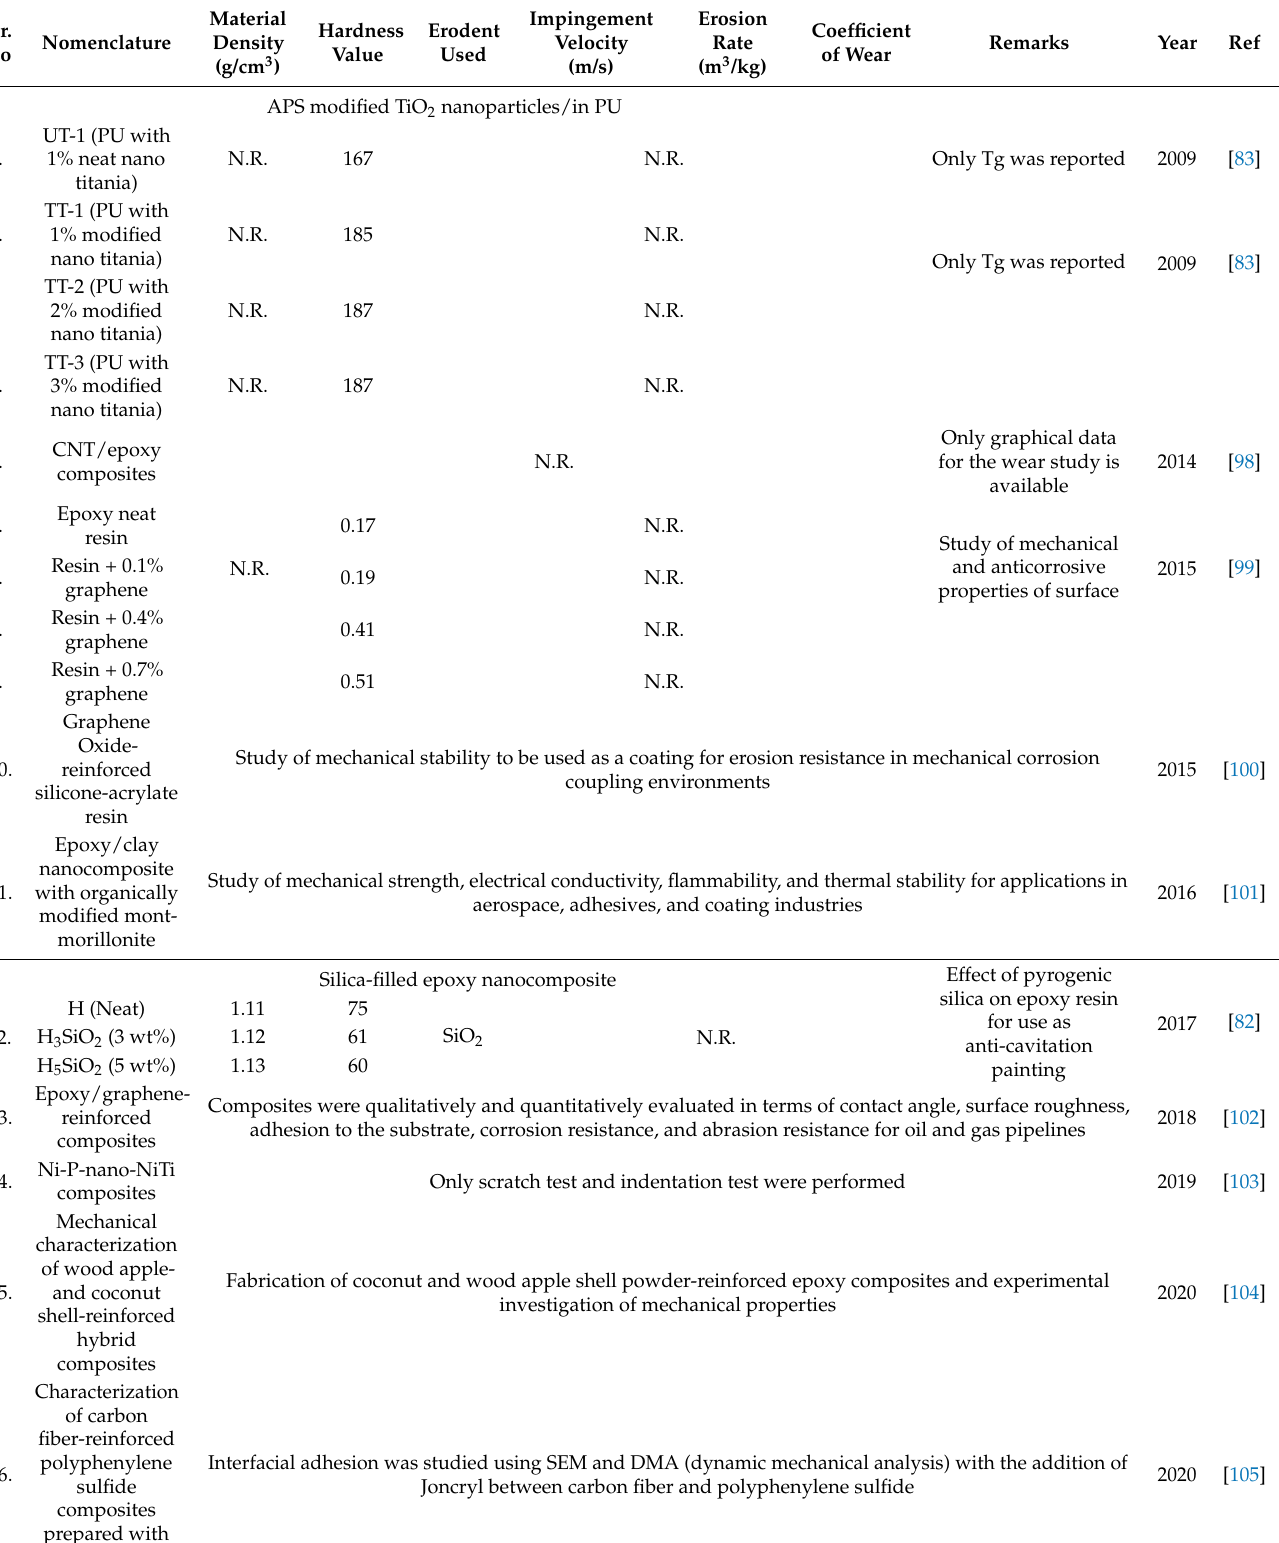
Table 3. Reported composites with properties related to